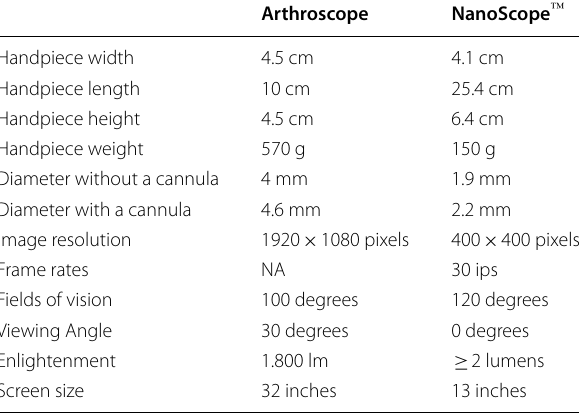
Table 2 Comparative technical characteristics of the 2 scopes